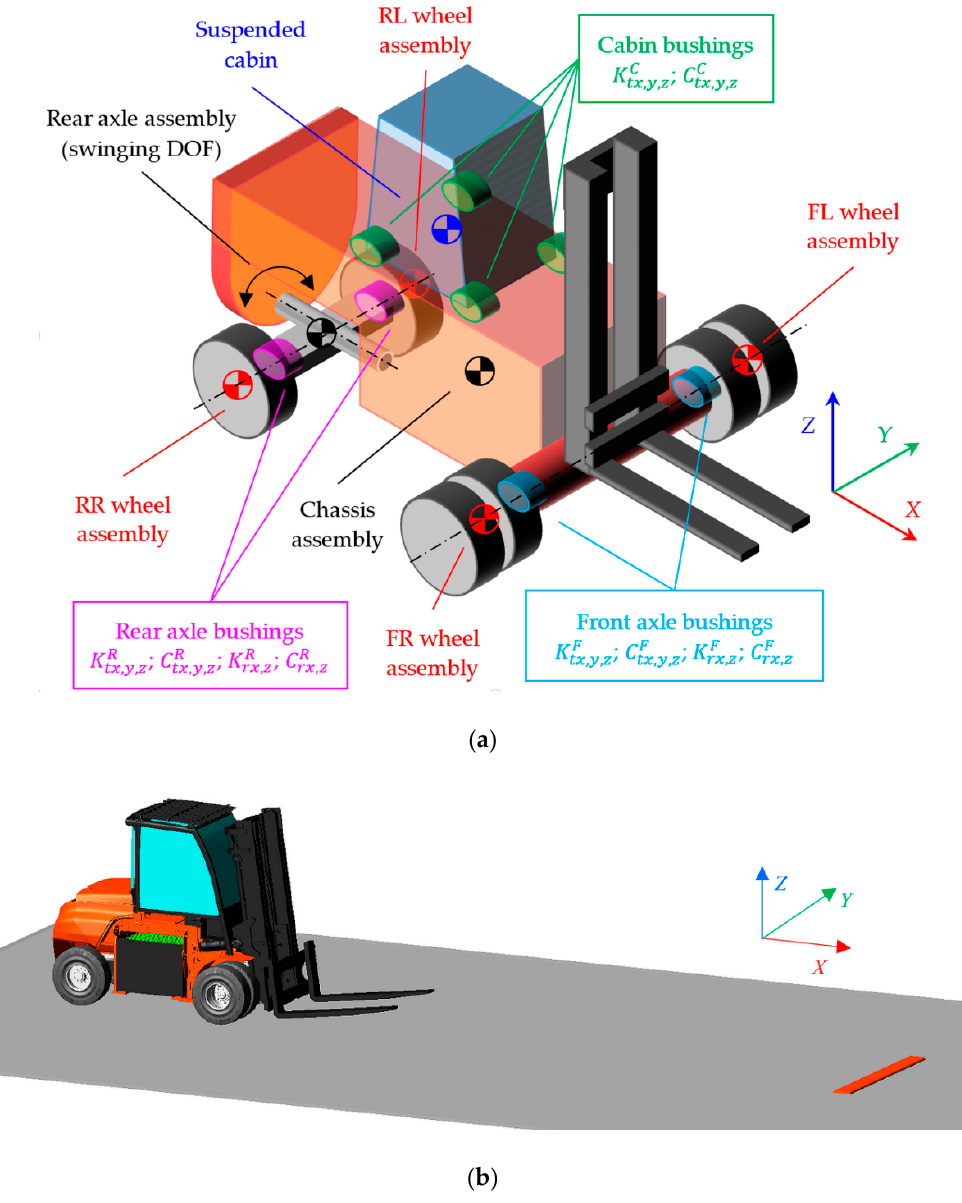
Figure 8. Numerical model: ( a ) Schematics with the main assemblies and parameters; ( b ) MSC Adams model after static equilibrium solution.